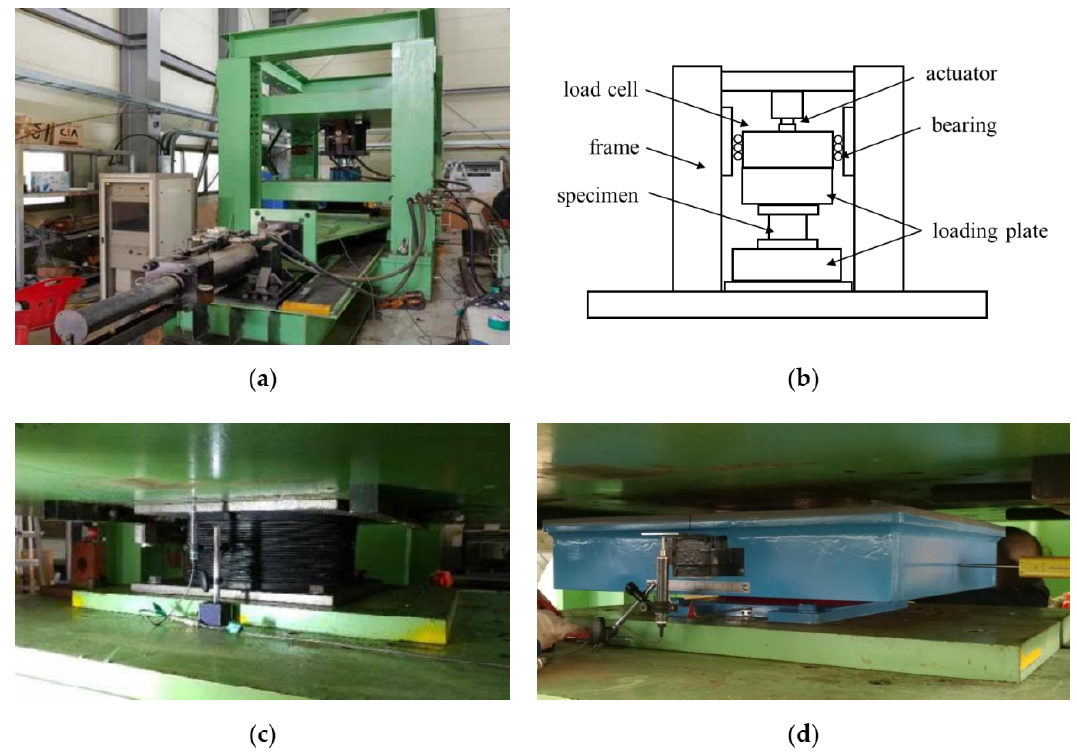
Figure 3. Compressive test setup: ( a ) photograph of compressive test machine; ( b ) conceptual drawing of compressive test; ( c ) installed Linear Variable Displacement Transducer (LVDT) for LRB and NRB; ( d ) installed LVDT for